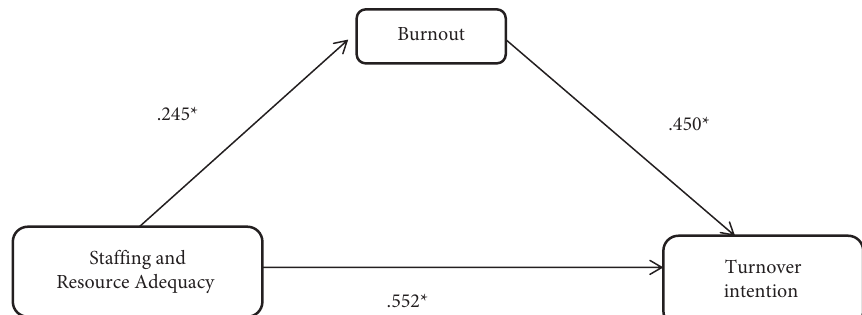
Figure 3: Standardized regression coefficients of the relationship between Staffing and Resource Adequacy and turnover intention as mediated by